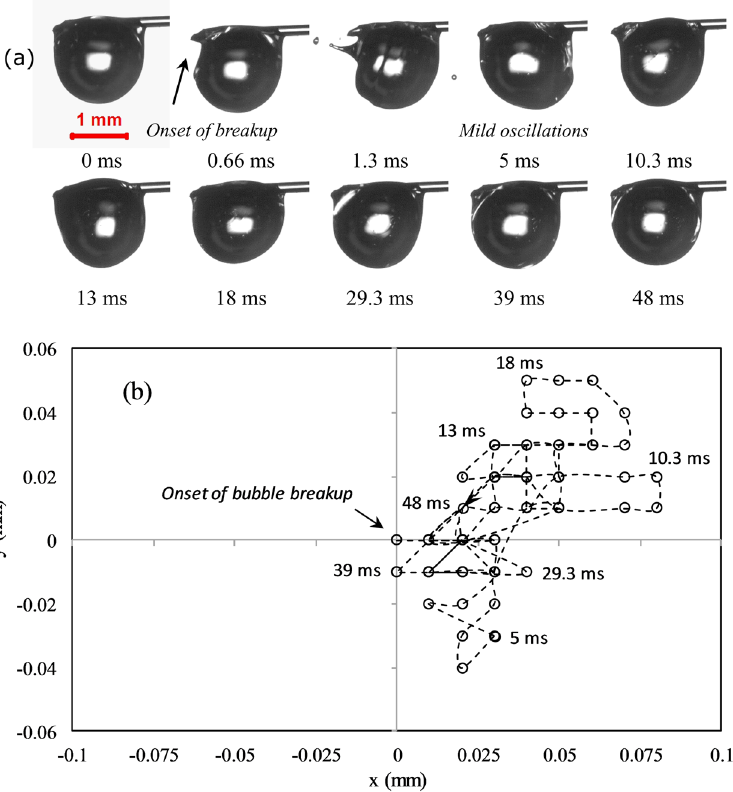
Figure 7. ( a ) Mild oscillations following a minor bubble breakup event ( α = 0.02) in a typical droplet with a low concentration of volatile component (B30) and ( b ) the trajectory of the droplet centroid following the onset of minor bubble breakup, indicating moderate oscillations of the